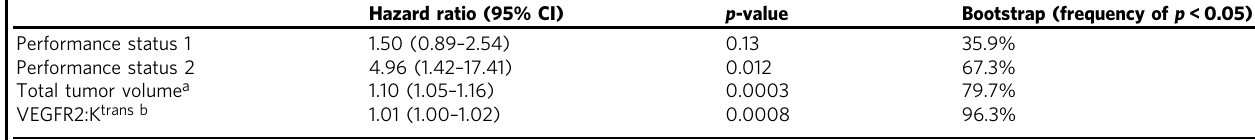
Table 4 Multivariate analysis of biomarkers before